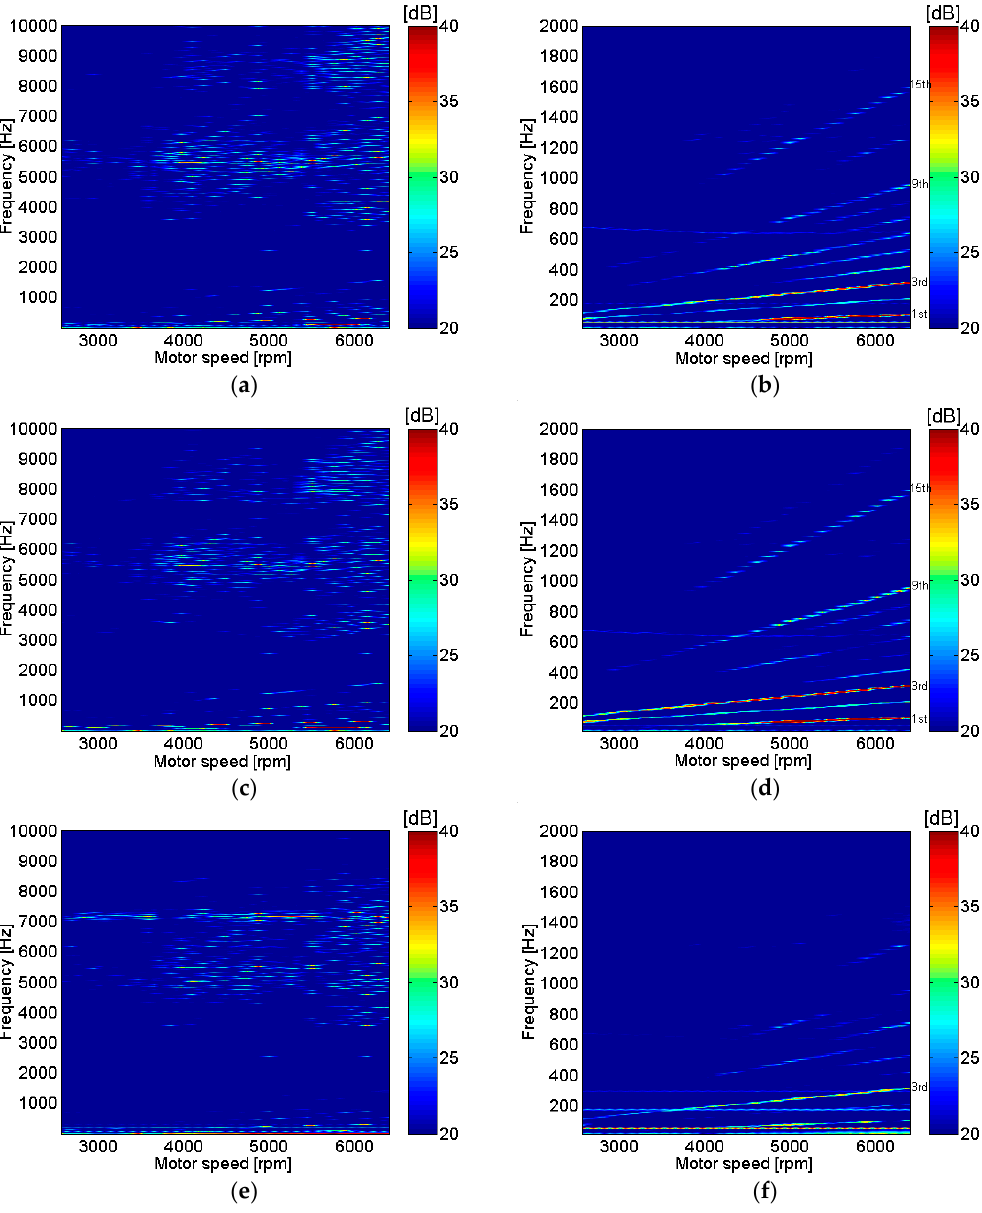
Figure 4. Motor noise measurement at different locations for motor run-up operation from 6 to 15 V with aluminum base plate support: ( a ) bottom end cap; ( b ) bottom end cap; ( c ) motor housing center; ( d ) motor housing center; ( e ) motor shaft center top; ( f ) motor shaft center top.